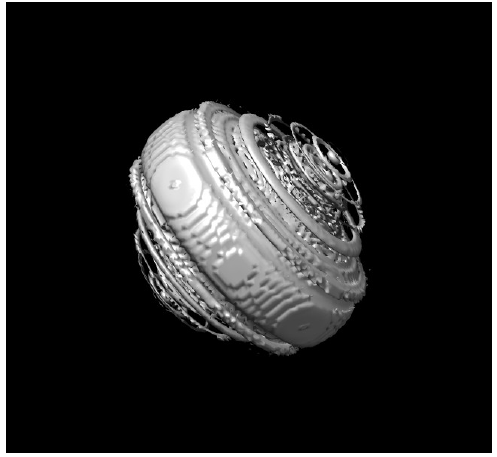
Figure 5. Reconstructed diffraction volume from one particle per shot (randomly oriented).